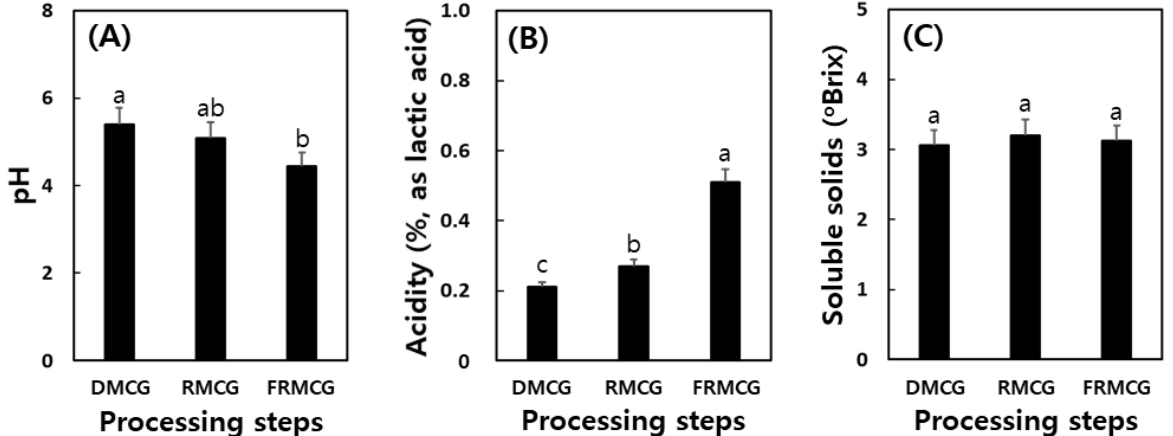
Figure 2. Change of pH ( A ), acidity ( B ), and soluble solids ( C ) during food processing steps of mountain-cultivated ginseng by the cocktail lactic acid bacteria. DMCG, dry mountain-cultivated ginseng; RMCG, red mountain-cultivated ginseng; and FRMCG, fermented red mountain-cultivated ginseng. All values are present as the mean ± SD of pentaplicate determination. Different letters correspond to the significant differences relating to the processing steps using Tukey’s multiple tests ( p < 0.05).